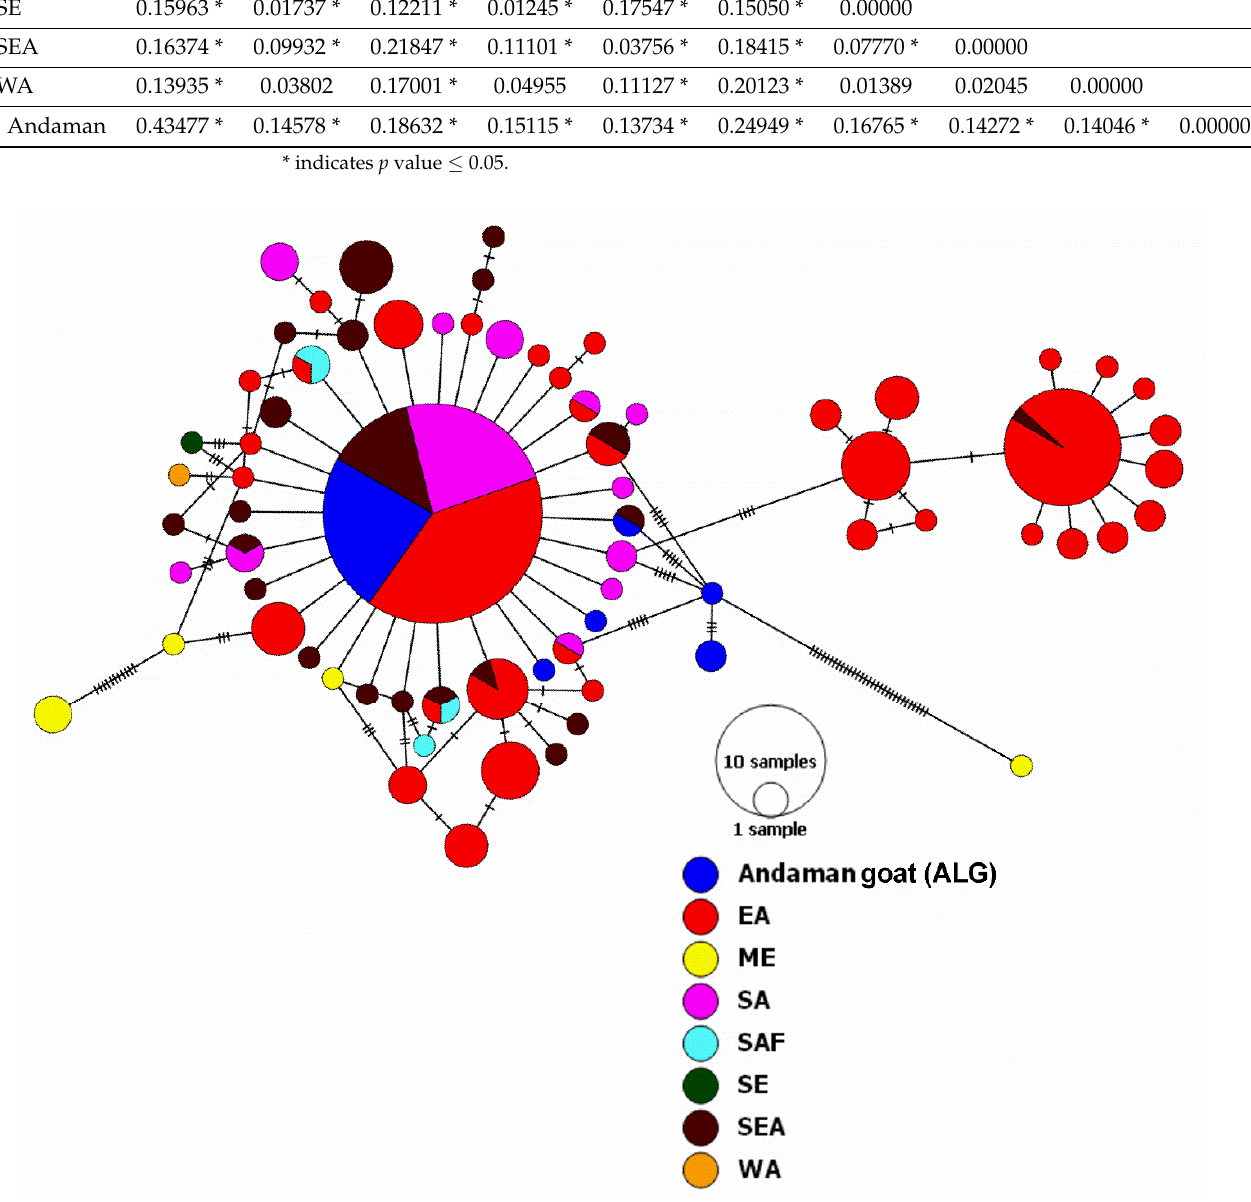
Figure 3. Haplogroup B of Andaman goats and its relationship with B haplogroup goats of di ff erent regions. The network was drawn in PopART ver. 1.7 [34]. Analysis was done based on 481 bp hypervariable region (HV1) of mitochondrial D-loop.